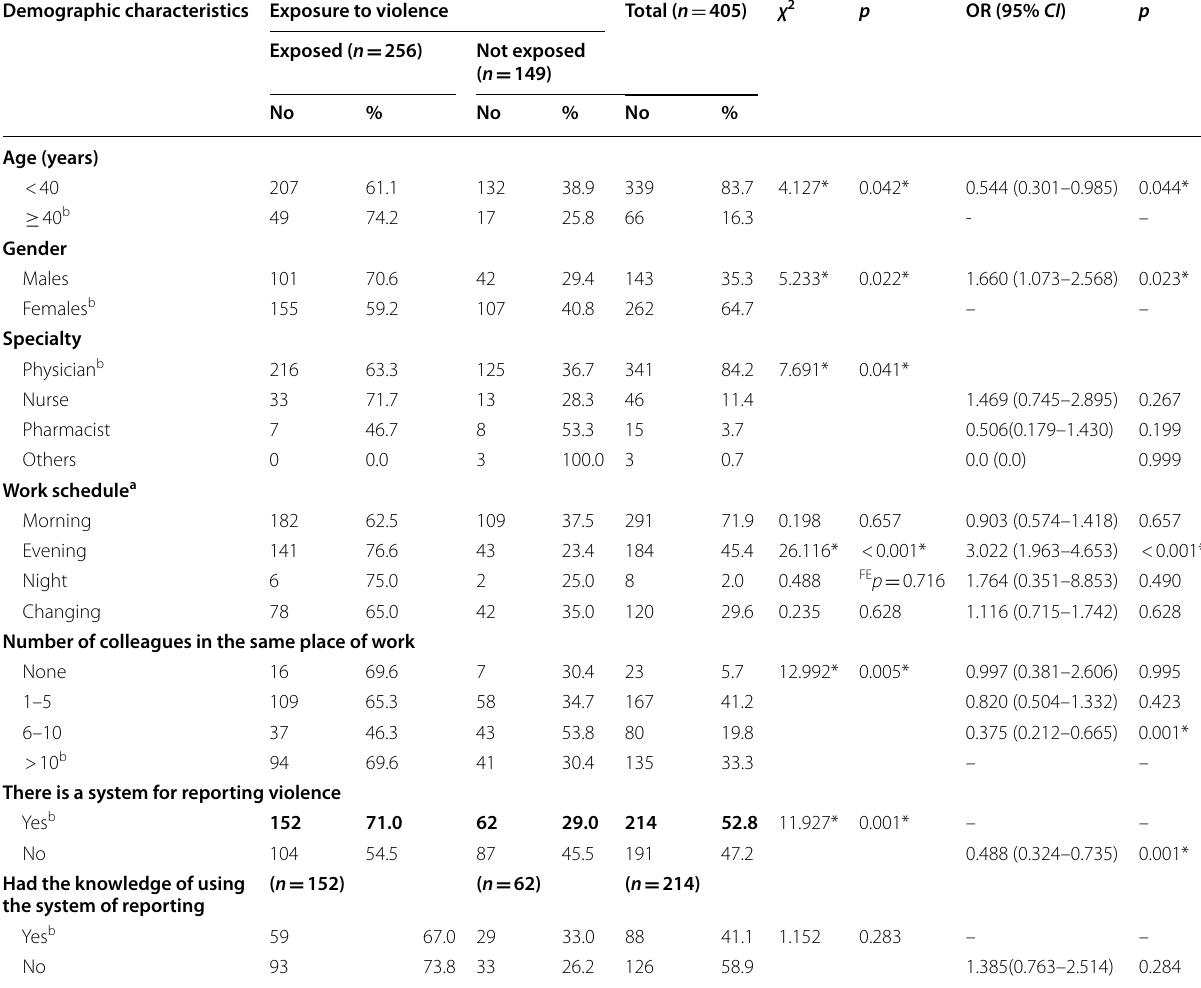
Table 2 Risk factors of workplace violence among the studied healthcare workers in context with the COVID‑19 pandemic in Egypt according to their demographic